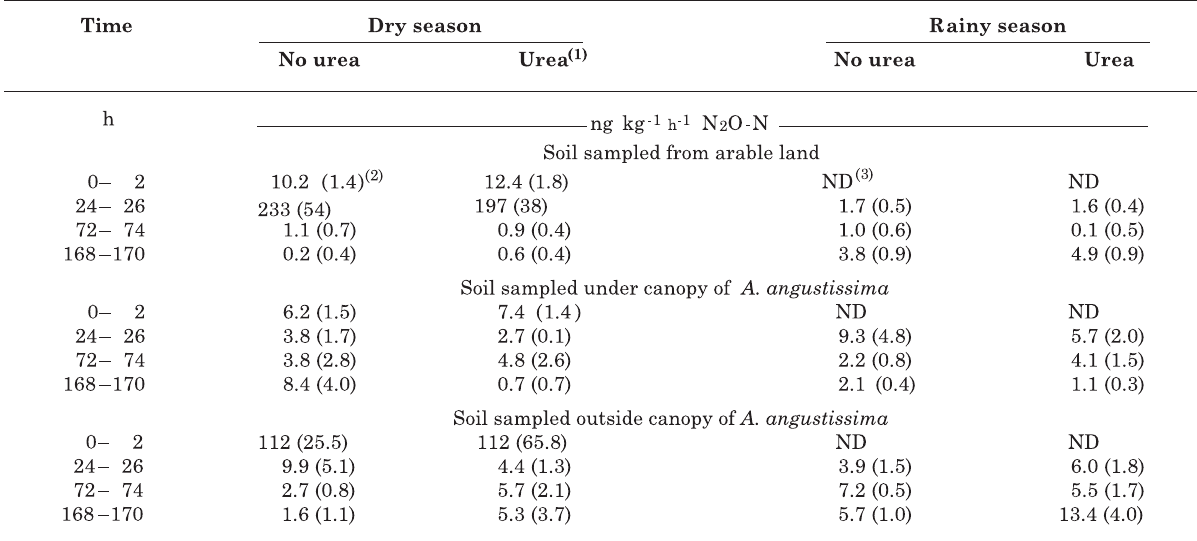
Table 3. N O emission from arable soil and soil sampled under and outside the canopy of Acacia angustissima 2 in the dry and rainy season and adjusted to 40 % water-holding capacity